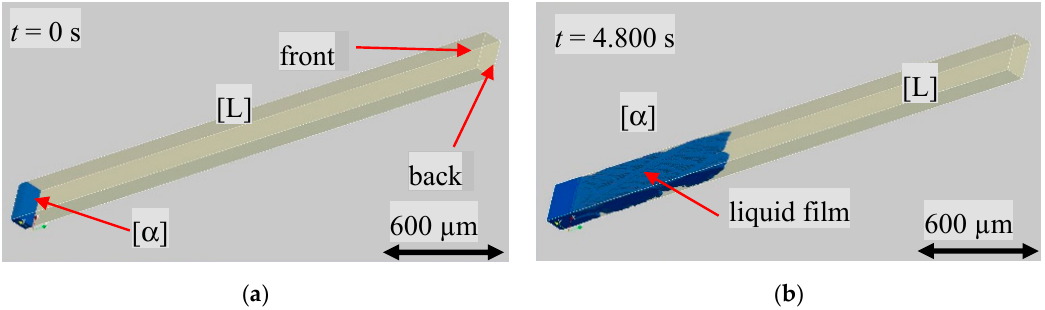
Figure 9. Three-dimensional representation of the α -phase (blue). The inner volume of the glass sample is delimited by white lines and the melt is shown in a semi-transparent yellow. The distance between the front and back corresponds to the 100 μ m inner depth of the glass sample. ( a ) Initial planar s/l interface, ( b ) dendritically solidification morphology shortly before a β nucleation event took place.